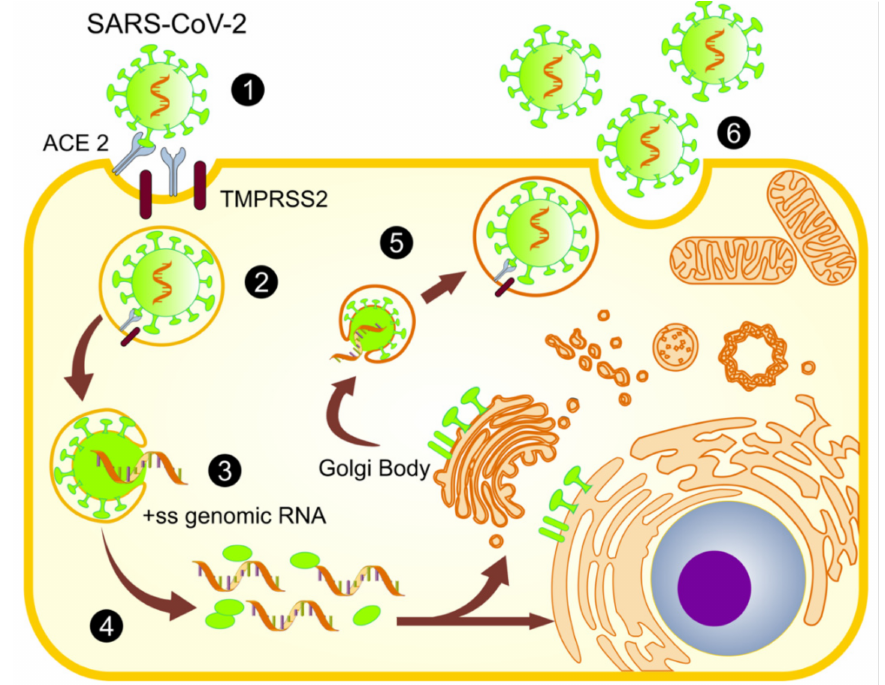
Figure 2. SARS-CoV-2 viral life cycle. (1) The spike protein of SARS-CoV-2 binds to receptor angiotensin-converting enzyme 2 (ACE-2), assisted by the transmembrane protease, TMPRSS2. (2) This binding promotes viral uptake and fusion at the cellular or endosomal membrane. (3) The virion releases its positive-sense single-stranded RNA (+ss RNA). (4) The release and uncoating of the incoming genomic RNA subject it to the immediate translation of two open reading frames (ORF 1 and ORF 1b), which results in the release of non-structural proteins, such as nsps, which creates a protective microenvironment for viral genomic RNA replication and transcription. (5) The translated structural proteins and newly produced genomic RNA translocate into rough endoplasmic reticulum (ER) membranes and transit through the ER-to-Golgi intermediate compartment, where they are assembled into a new virion. (6) Finally, virions are secreted from the infected cell by exocytosis